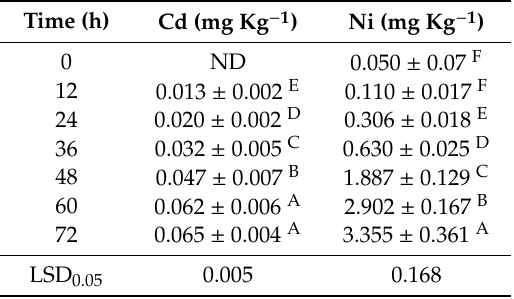
Different letters per each line mean a significant difference ( p ≤ 0.05 ). Values are average of means and bars represent the standard error ( n = 6 ). LSD 0.05 is the least significant difference at the probability level of 0.05. ND: not detected.